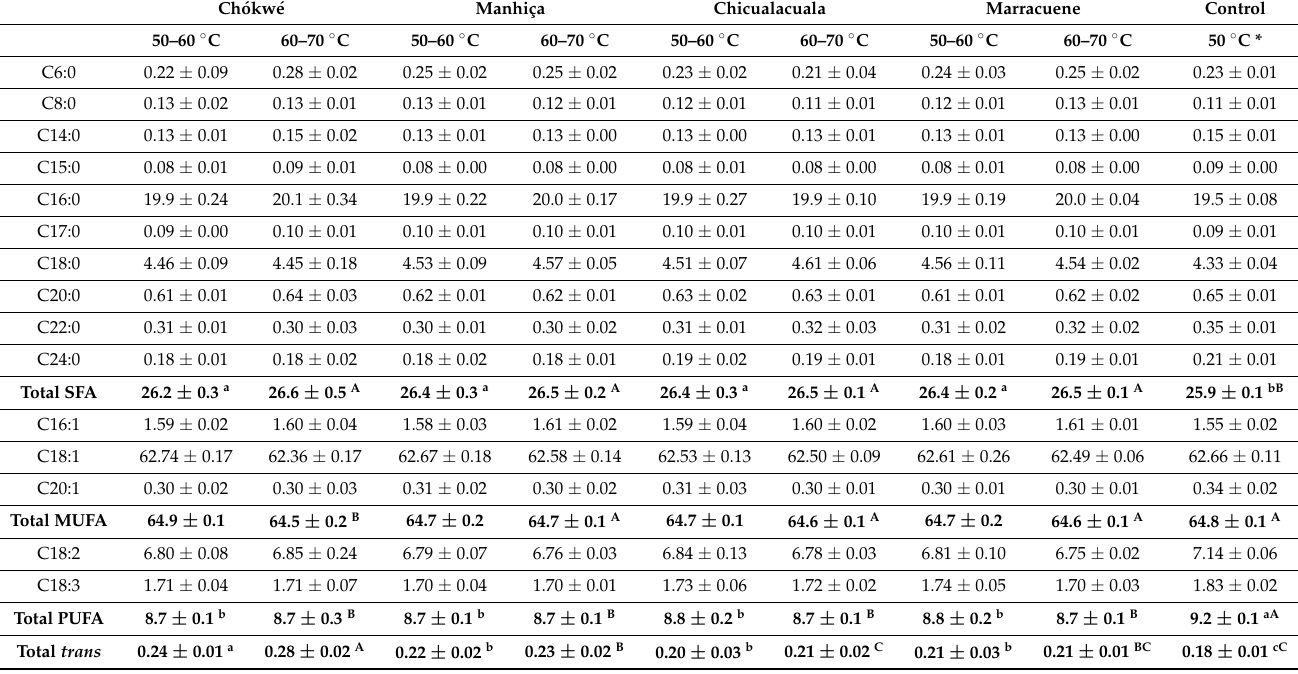
Table 1. Fatty acid composition relative percentage (%) (mean ± standard deviation, n = 3 × 2) of oils extracted from the flour obtained at different temperatures from Strychnos madagascariensis fruits harvested and prepared by the communities of Ch ó ckw é , Manhiça, Chicualacuala, and Marracuene, in southern